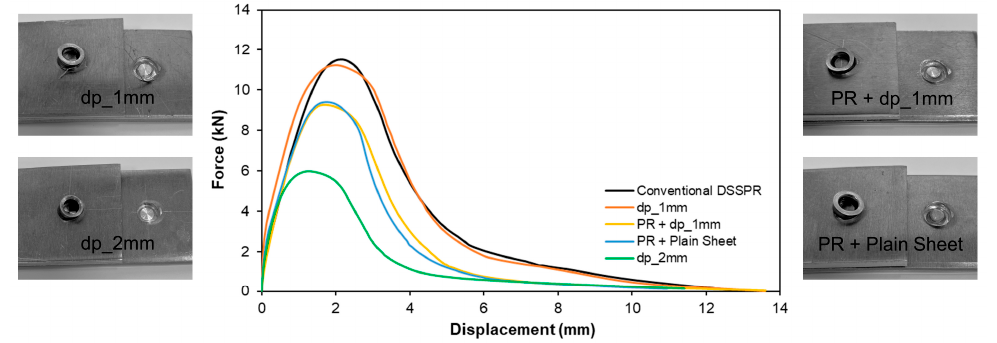
Figure 10. Evolution of force with displacement for the shear tests of the different modifications of DSSPR with the corresponding photographs of the specimens after detachment.